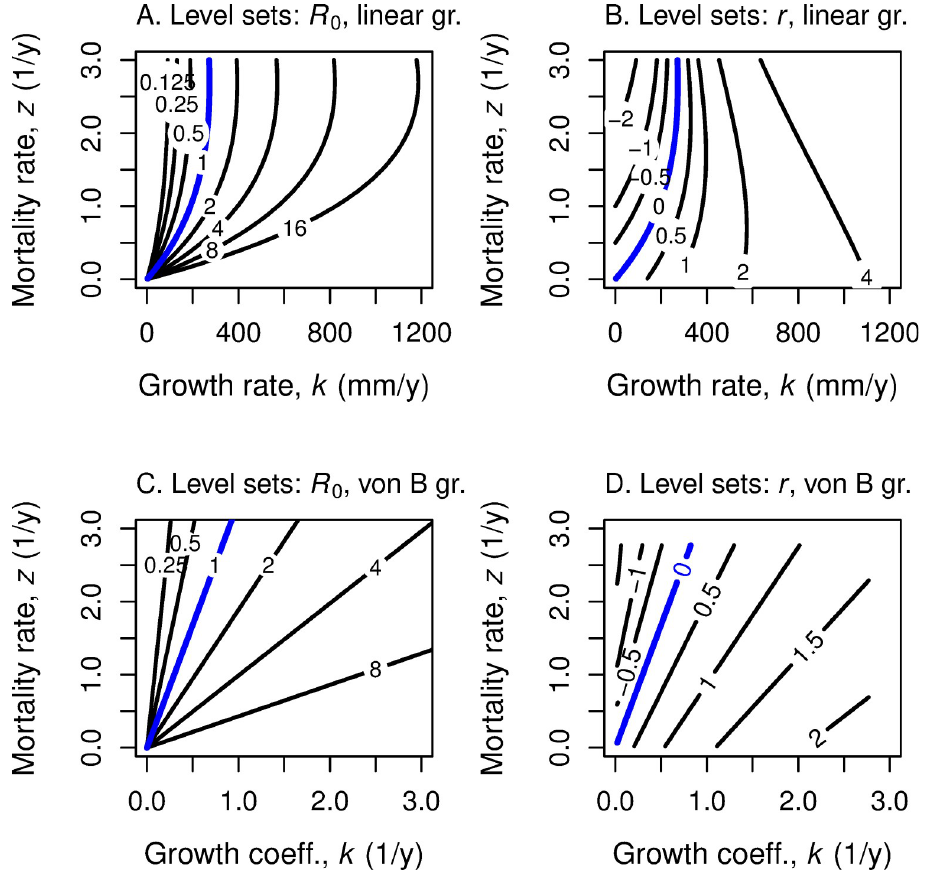
Fig 13. Level sets of fitness as functions of growth rate and mortality rate. Level sets of fitness as R 0 (A, C) and fitness as r (B, D) in relation to mortality rate z and growth coefficient k , for linear growth (A, B) and for von Bertalanffy growth (C, D). Combinations of growth rate k and mortality rate z in the region below and to the right of the blue line have R 0 > 1 and r > 0 and thus indicate the lineage is increasing. Such a figure helps in the evaluation of the trade-offs, say, in the search for a more substantial but riskier food